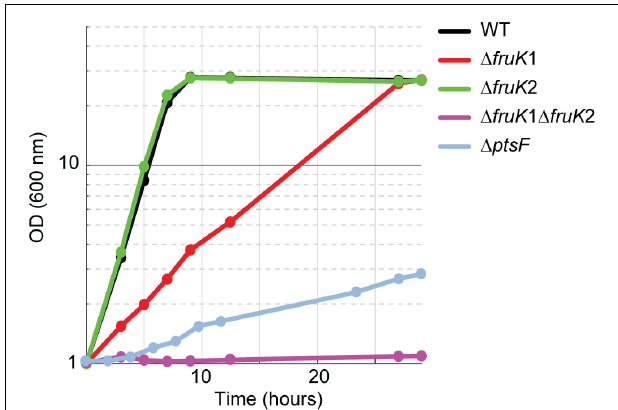
FIGURE 2 | Growth on 2% fructose of strains lacking parts of the canonical fructose utilization pathway, fructose-specific PTS ( ptsF ), or 1-phosphofructokinases ( fruK1 , fruK2 ). Data represent one of two individual cultivations that differed <